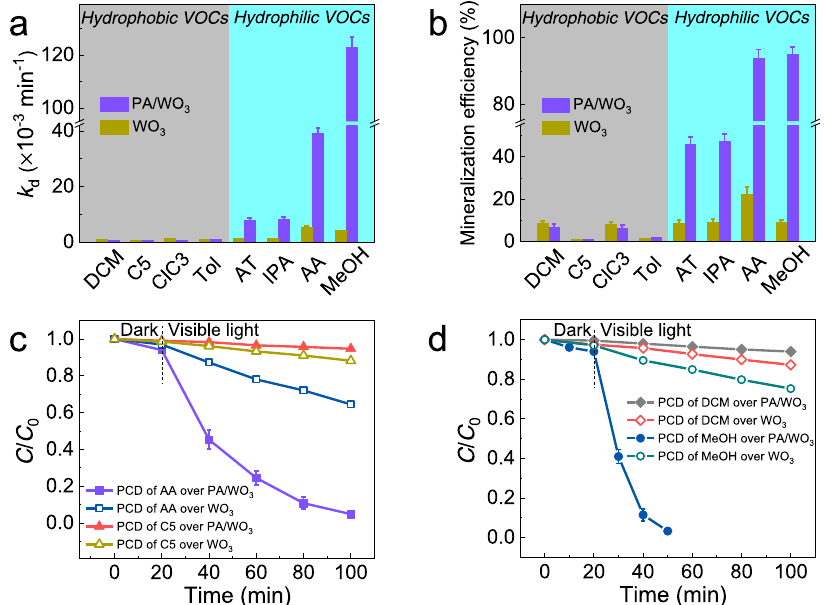
Fig. 6 Selective removal of hydrophilic volatile organic compounds (VOCs) over PA/WO 3 . a PCD rate constants ( k d ) and b the mineralization ef fi ciencies of different VOCs over bare WO 3 and PA/WO 3 . PCD of the mixture of c AA and C5 and d MeOH and DCM. Error bars are de fi ned as standard deviation. Experimental conditions: [VOC] 0 = 120 ppmv; visible light ( λ > 420 nm) intensity of 2.2 mW/cm 2 ; sample amount of 50 mg; RH 65%; reaction temperature of 30 °C. AA acetaldehyde, IPA isopropanol, AT acetone, MeOH methanol, DCM dichloromethane, C5 n -pentane, ClC 3 n -chloropropane, Tol